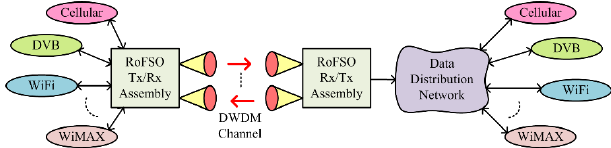
Figure 42. UOC network with DWDM access technique for the NGN.